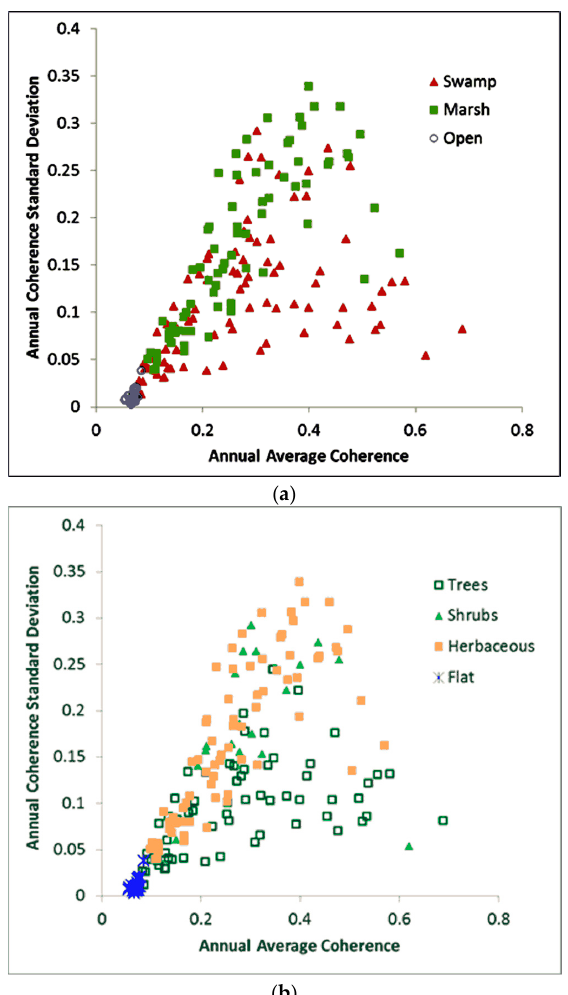
Figure 7. Annual average coherence and standard deviation of 60 wetlands over three-year ice-off period (total of 180 points): ( a ) sorted by wetland type; ( b ) sorted by wetland structure.